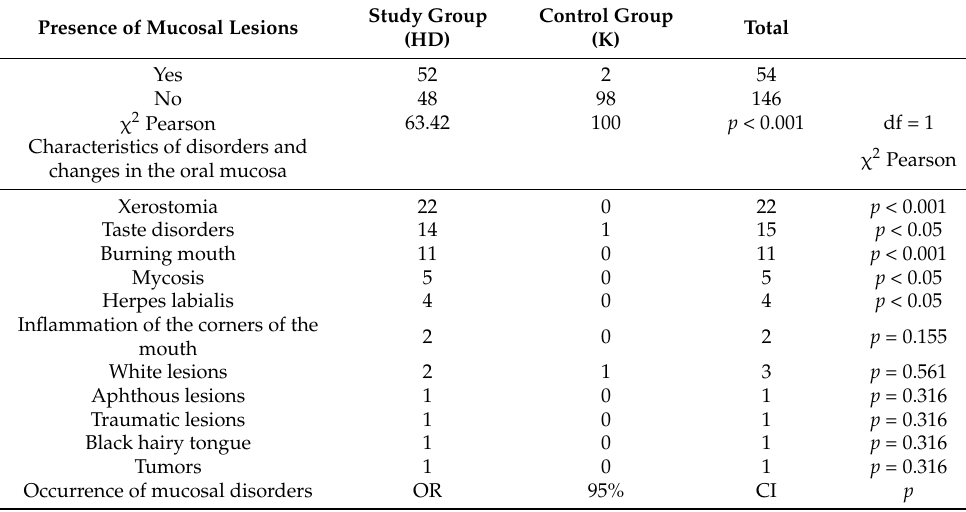
Table 5. Characteristics of changes and disorders of the oral mucosa in the studied groups (HD,